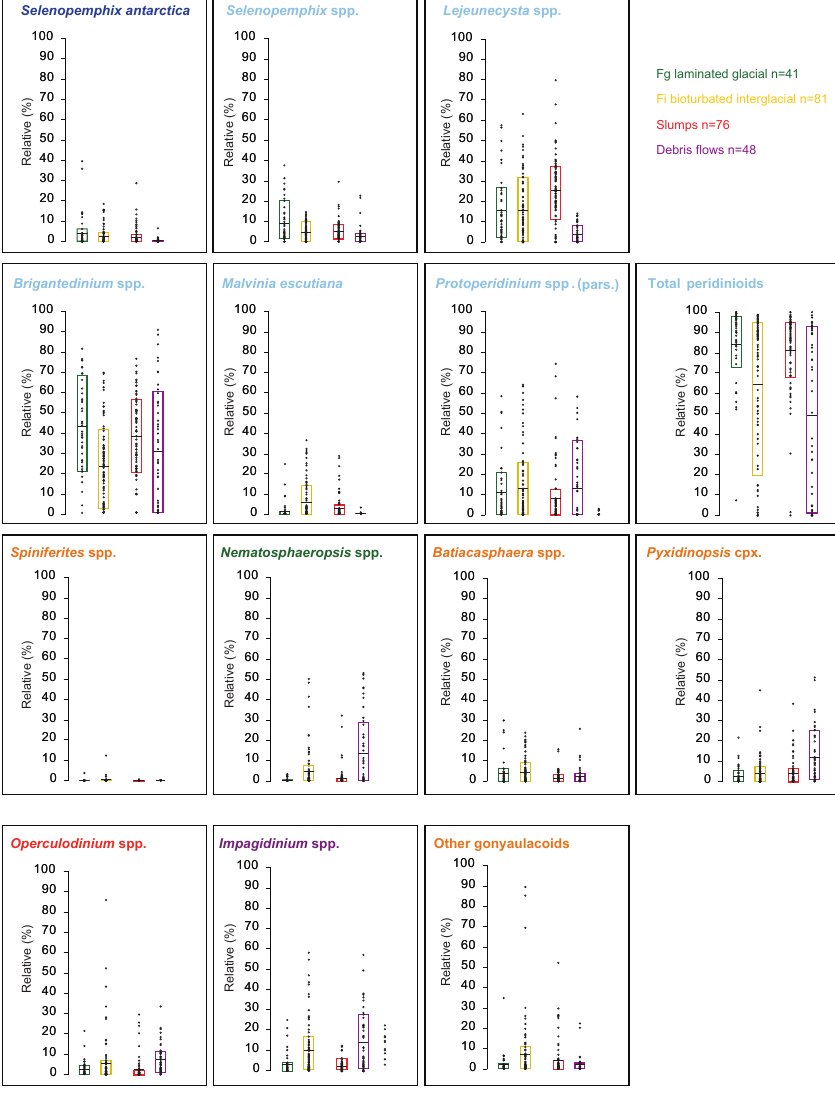
Figure 7. Relative abundance of in situ eco-groups within various lithologies at Hole U1356A. Average (black line) and 17–83% percentile (coloured bar) of relative abundances of grouped taxa from samples from the different facies (Salabarnada et al.,